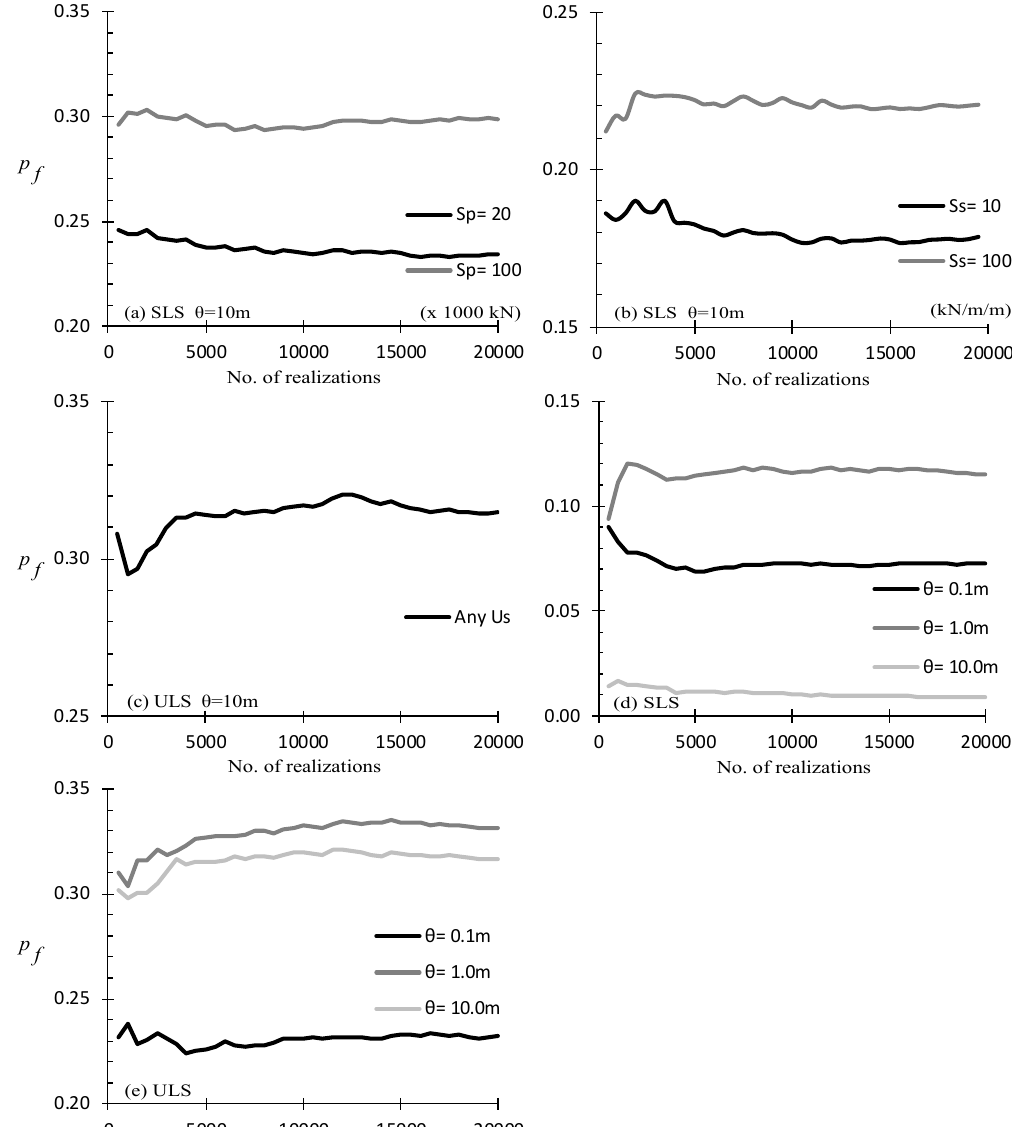
Figure A1. p f vs. number of realizations for di ff erent values of ( a ) pile sti ff ness ( S p ), ( b ) soil sti ff ness ( S s ) , ( c ) soil strength ( U s ) and spatial correlation length ( θ ) for ( d ) the SLS state and ( e ) the ULS